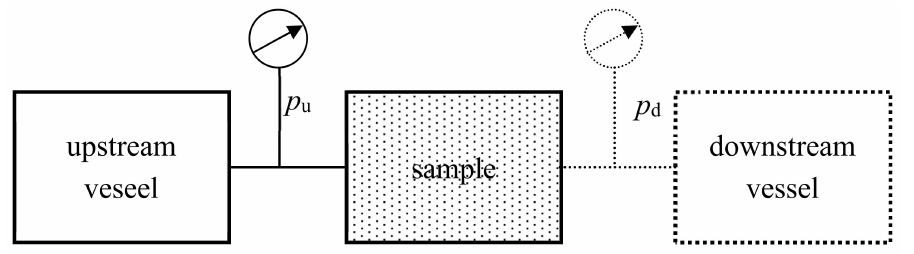
Figure 1. Schematic diagram of devices for the pulse decay tests.